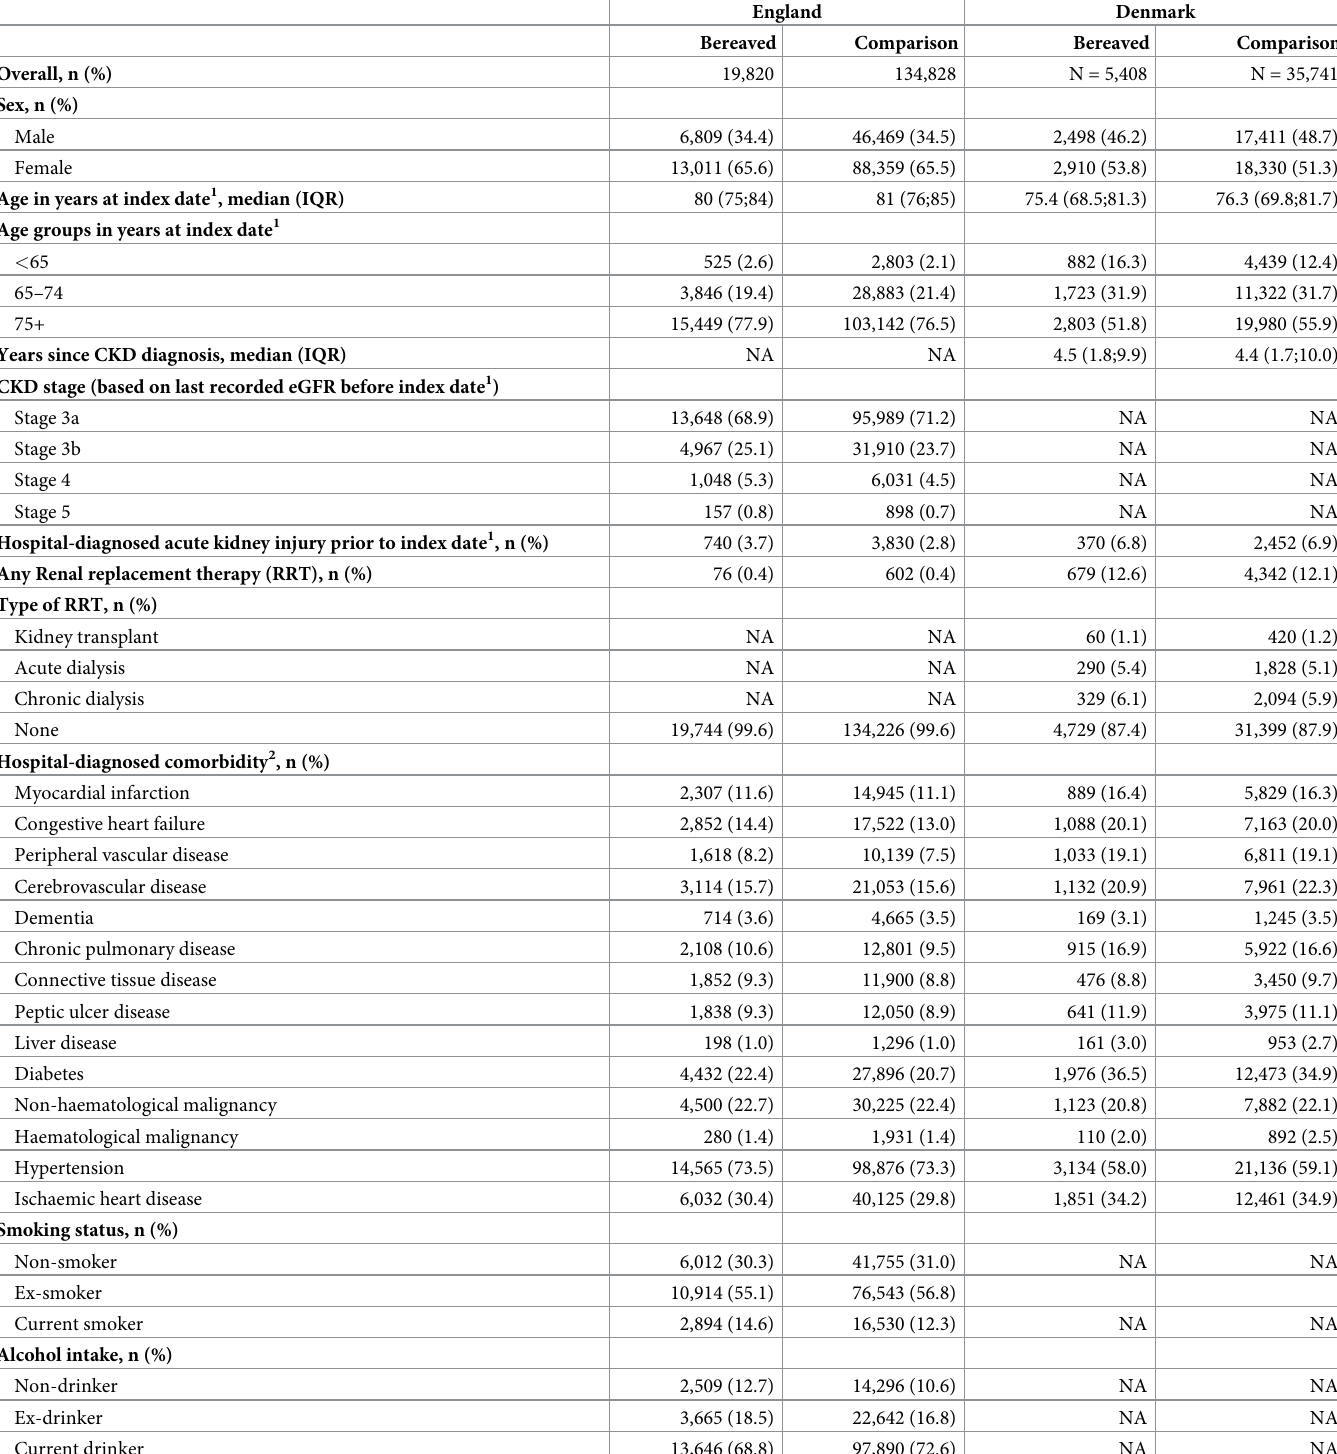
Table 1. Baseline characteristics of people with CKD who were bereaved and their non-bereaved matched comparisons in England (1998–2018) and Denmark (1997–2016).